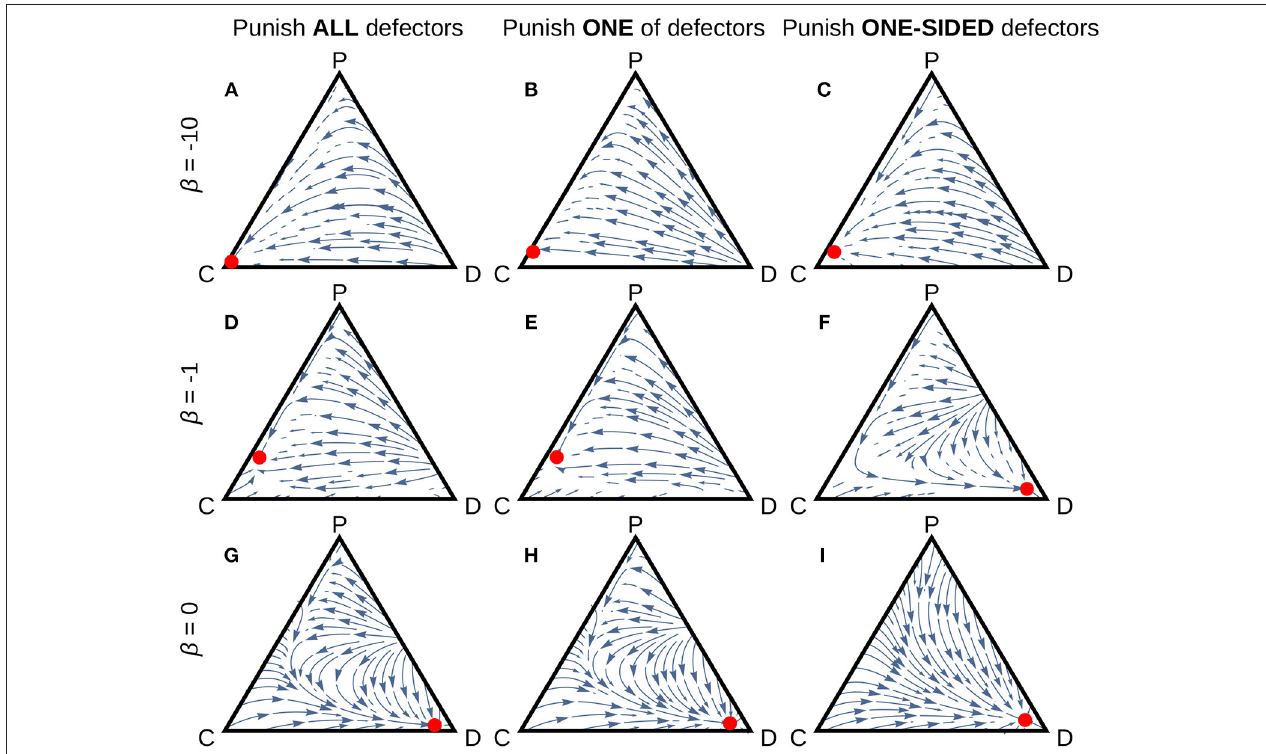
FIGURE 5 | The replicator–mutator dynamics of cooperators (C), defectors (D), and third-party punishers (P) if we assume the donation game. A population is full of one of them at the “C,” “D,” and “P” corners, respectively. Their frequencies are equal at each center of each simplex. Arrows represent trajectories starting from various initial states. Red points represent stable outcomes. (A,D,G) The ALL variant. (B,E,H) The ONE variant. (C,F,I) The ONE-SIDED variant. We set (A–C) β = − 10. (D–F) β = − 1. (G–I) β = 0. Parameters: c = 1, b = 2, F = 4, C = 1.5, w = 0.1, and µ = 0.01. Note that we omit the results if β > 0 in which defectors